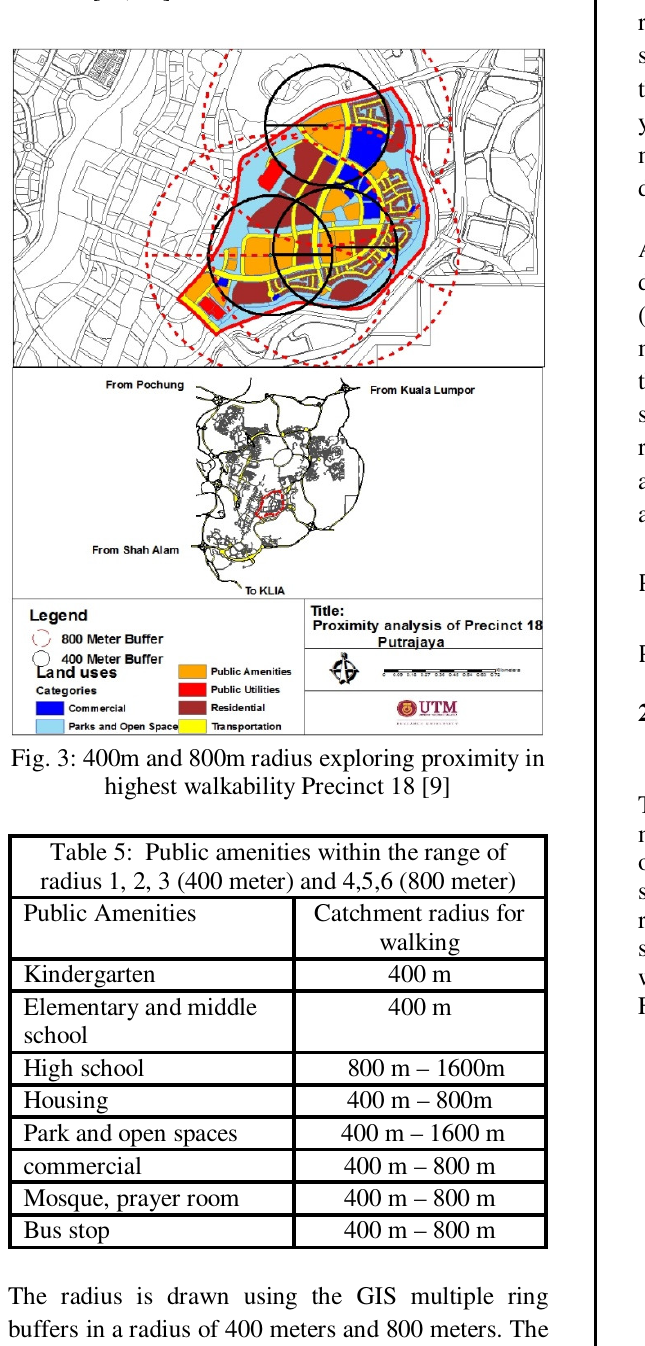
Fig.4: 400m and 800m radius exploring proximity